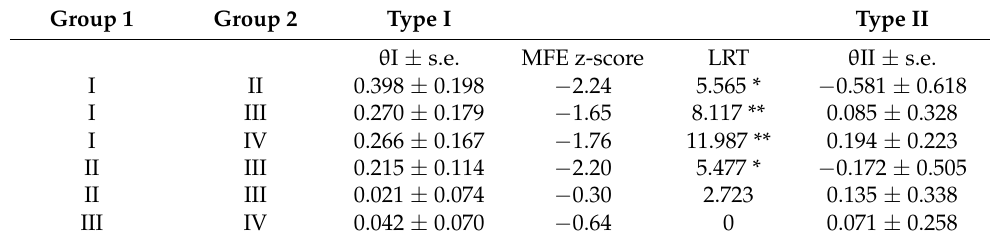
Table 2. Function divergences of ARF gene